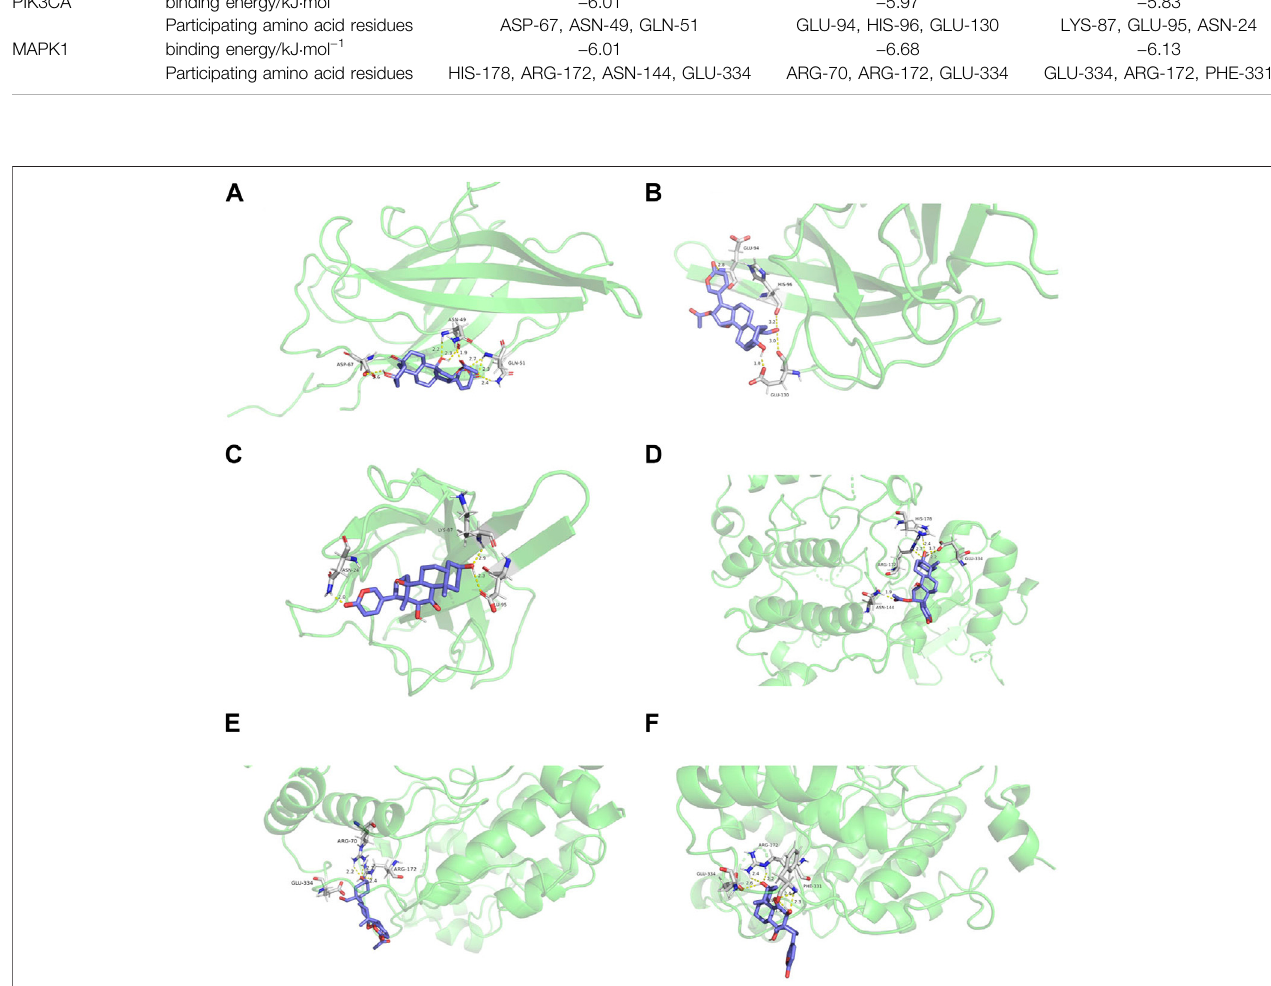
FIGURE 10 | Molecular docking structure diagram (A) . PIK3CA and 5 β -hydroxybufotalin (B) . PIK3CA and 19-oxo-cinobufagin (C) . PIK3CA and bufarenogin (D) . MAPK1 and 5 β -hydroxybufotalin (E) . MAPK1 and